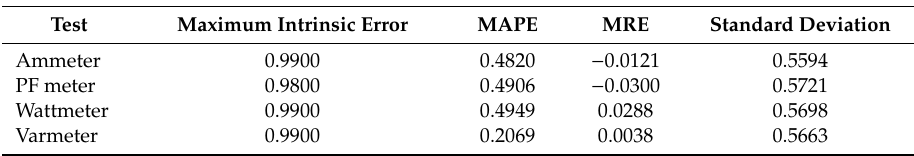
Table 6. Current magnitude distortion test: maximum intrinsic error (%), MAPE (%), MRE (%), and standard deviation: current variation.